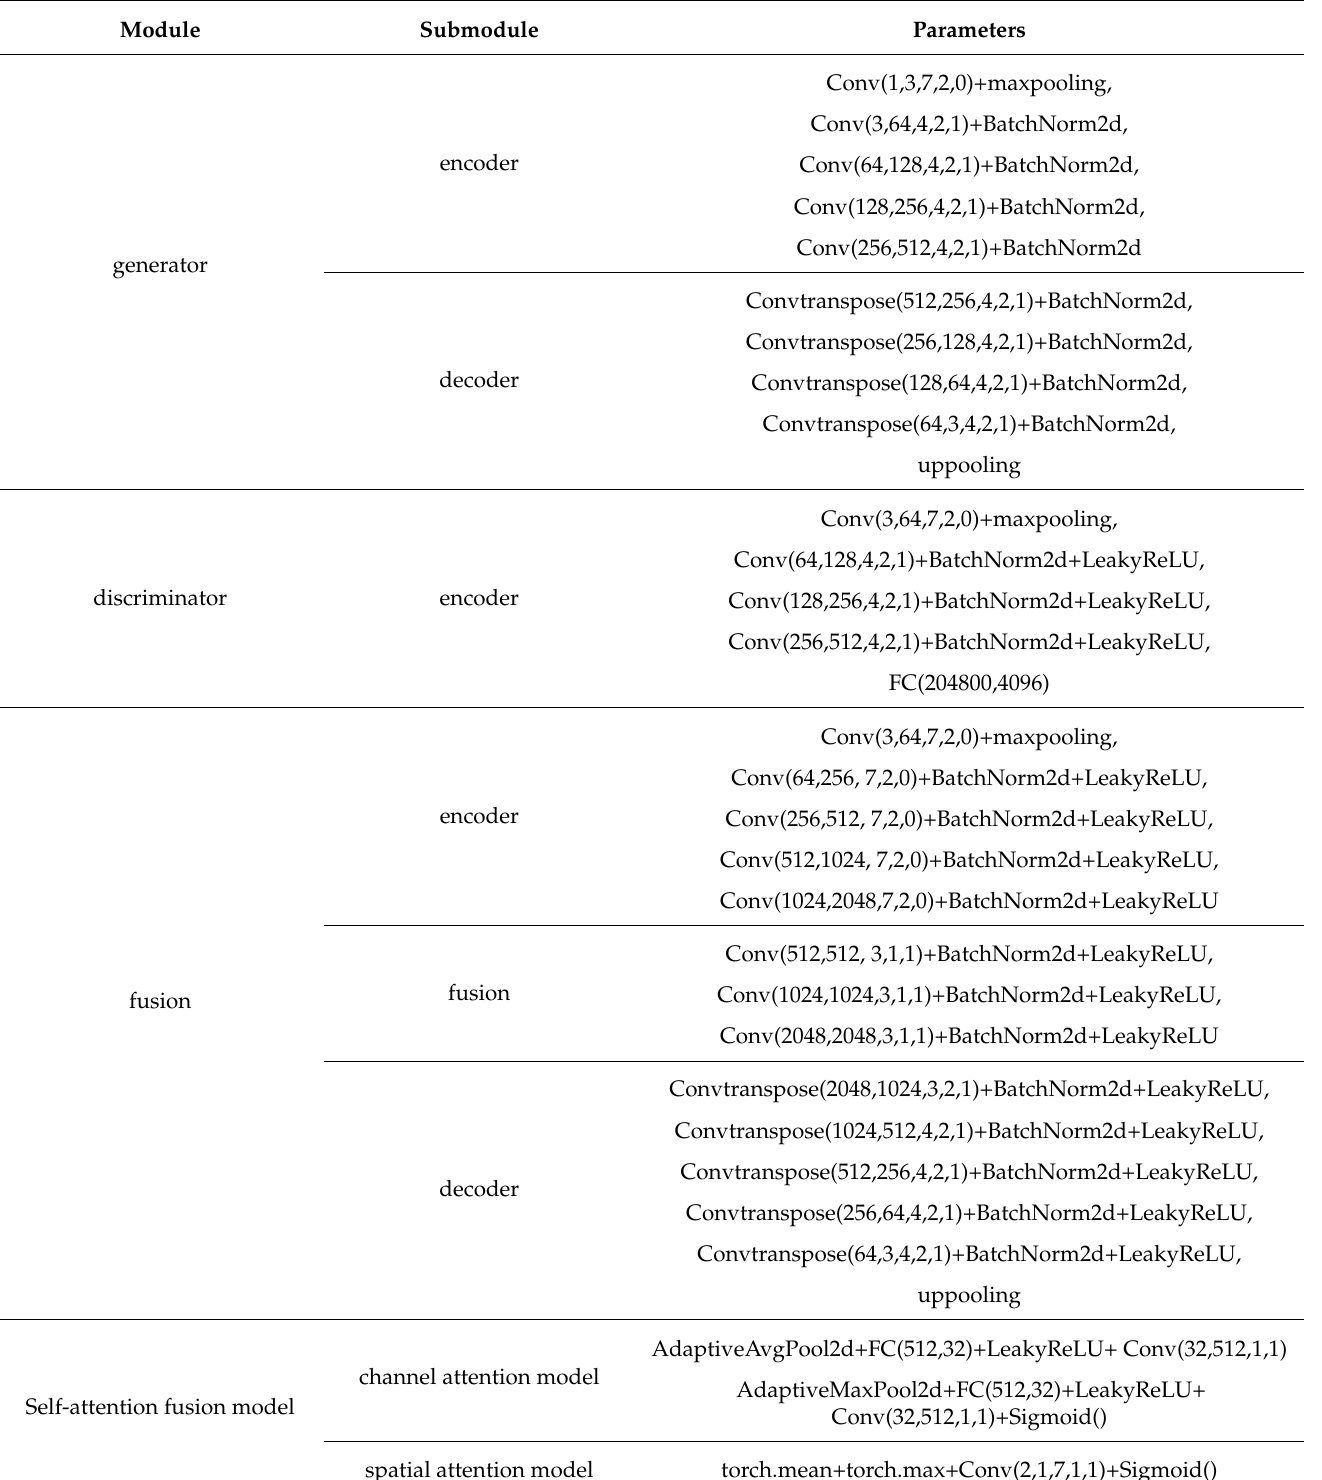
The detailed parameters of GF-detection are listed in the Table 1. Table 1. Parameters of the main module of